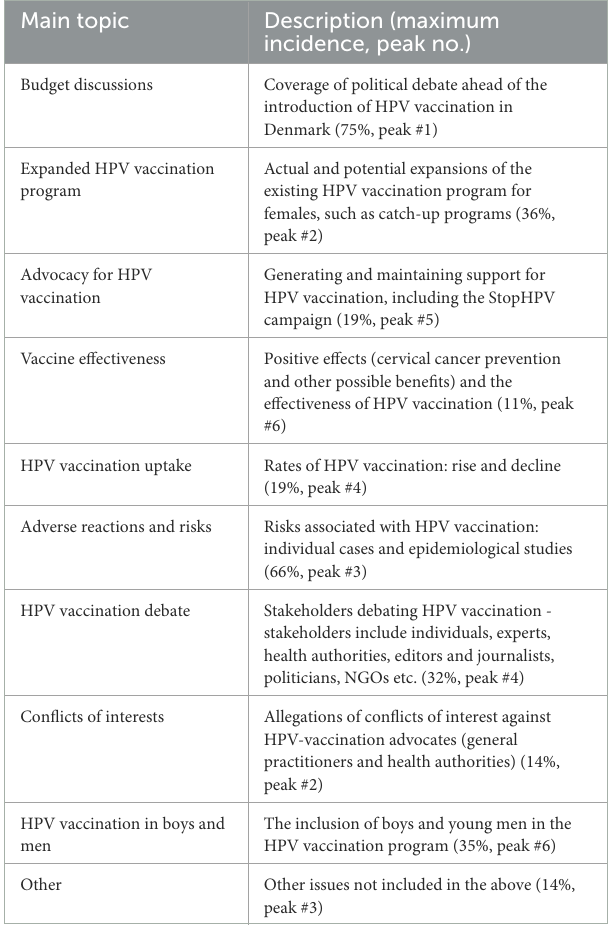
TABLE 2 Main topics and their highest incidence. Main